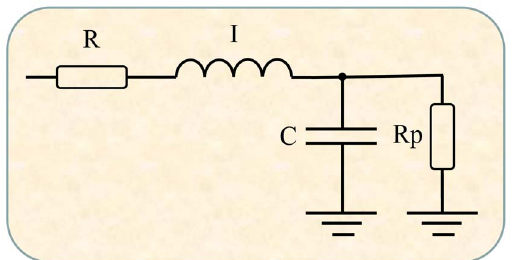
Figure 1. Electrical representation of the two-compartment model used to analyze respiratory impedance. Resistance (R), inductance (I) and capacitance (C) are the analogs of mechanical resistance, inertance and compliance, respectively. This model contrib- utes to gain additional insight into anatomical or pathophysiological changes in the studied subjects allowing the evaluation of central (R) and peripheral (Rp) airway resistance.